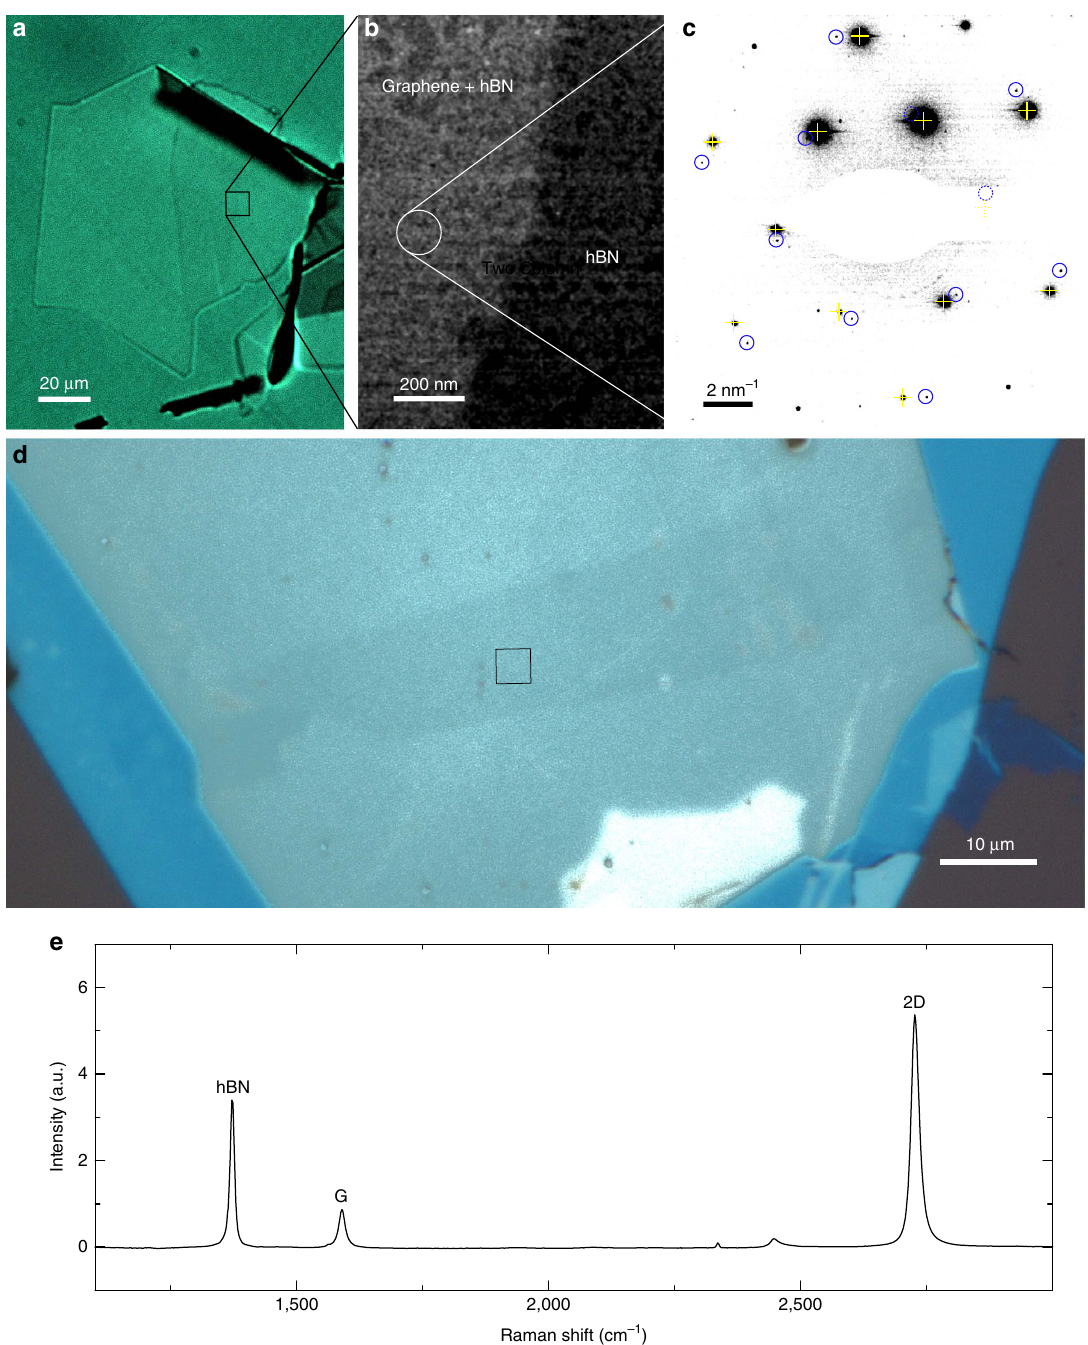
Figure 4 | TEM and Raman spectroscopy. ( a ) Optical transmission image of a graphene flake adhered to hBN on PPC/PDMS. ( b ) Dark-field tilted beam TEM image of region indicated in a . A discontinuous layer of amorphous carbon is visible. The objective aperture has been positioned to provide lighter contrast from the graphene region. ( c ) Selected area electron diffraction pattern from region indicated in b . The contrast has been enhanced to show both the monolayer graphene diffraction pattern (reflections indicated with blue circles) alongside the hBN diffraction pattern (indicated with yellow crosshairs). Points masked by the beam stop or by nearby stronger reflections are indicated with dashed versions of the same. ( d ) Enhanced contrast optical image of the encapsulated graphene. The boxed region indicates the region where the spectrum in e was acquired. Maps of the I (2D) /I ( G ) ratio and G peak full width at half maximum (FWHM) are available in Supplementary Fig. 6. ( e ) Raman spectrum of hBN-encapsulated graphene fabricated by the hot pick-up method, normalized to the G peak intensity. The I (2D) /I ( G ) peak ratio is 5.8 (with Lorentzian fits to the peaks ( R 2 4 0.994) indicating a ratio of 6.12 ± 0.02), with a FWHM of 14.2 ± 0.5cm (cid:2) 1